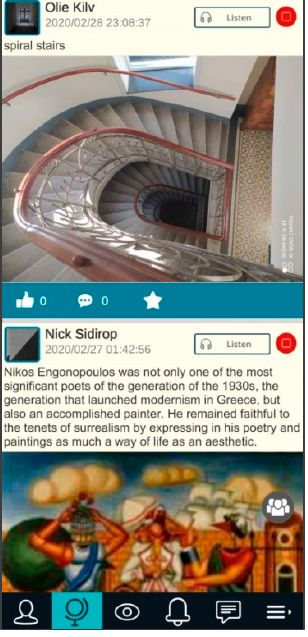
Figure 9. An example screen of a user’s news feed